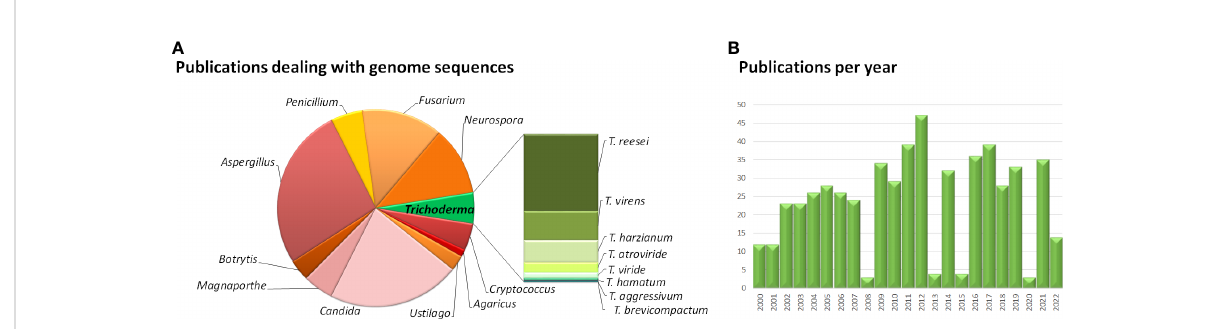
FIGURE 1 Overview of studies dealing with fungal genomes. (A) Results of a Pubmed search for "genome sequences ” of the respective fungi. (B) Number of studies dealing with „ Trichoderma genome sequences ” per year published in Pubmed. The website pubmed.ncbi.nlm.nih.gov/was accessed in August